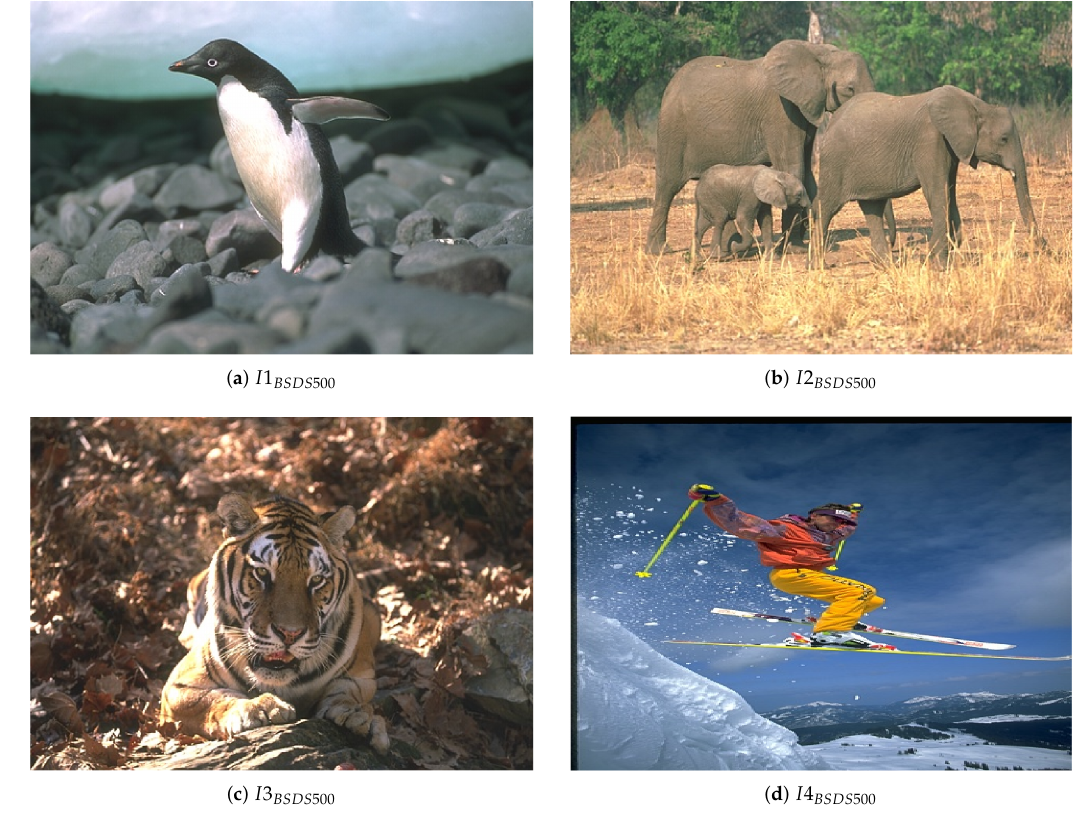
Figure 2. Examples of BSDS500 images.